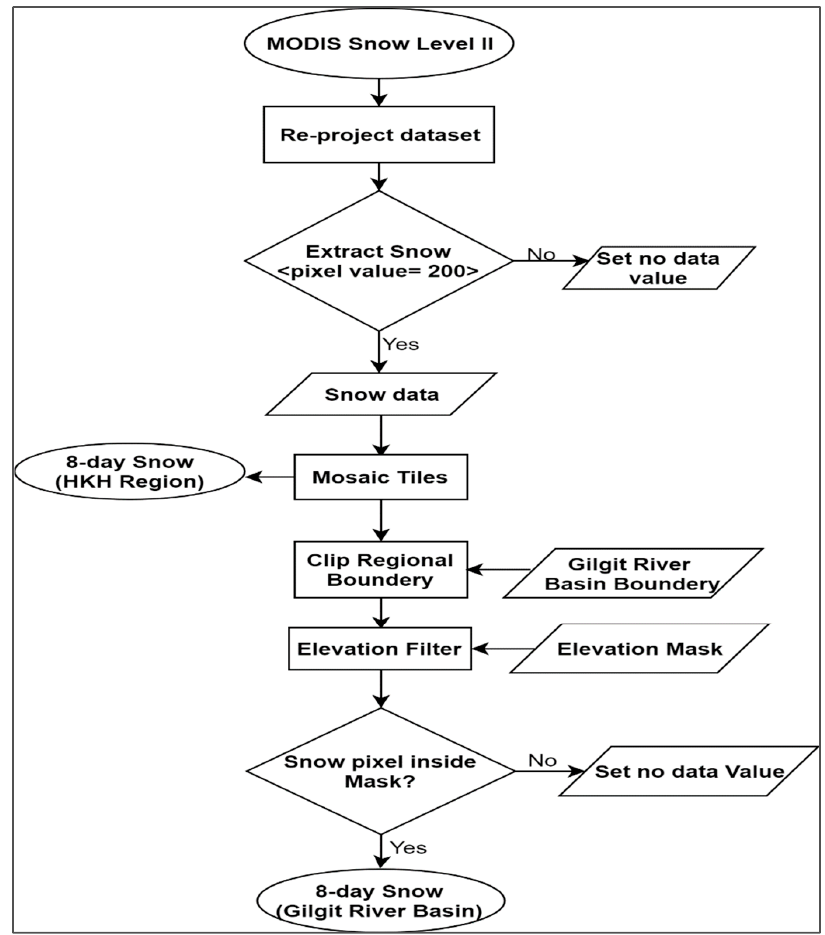
Figure 3. Process for snow extraction.